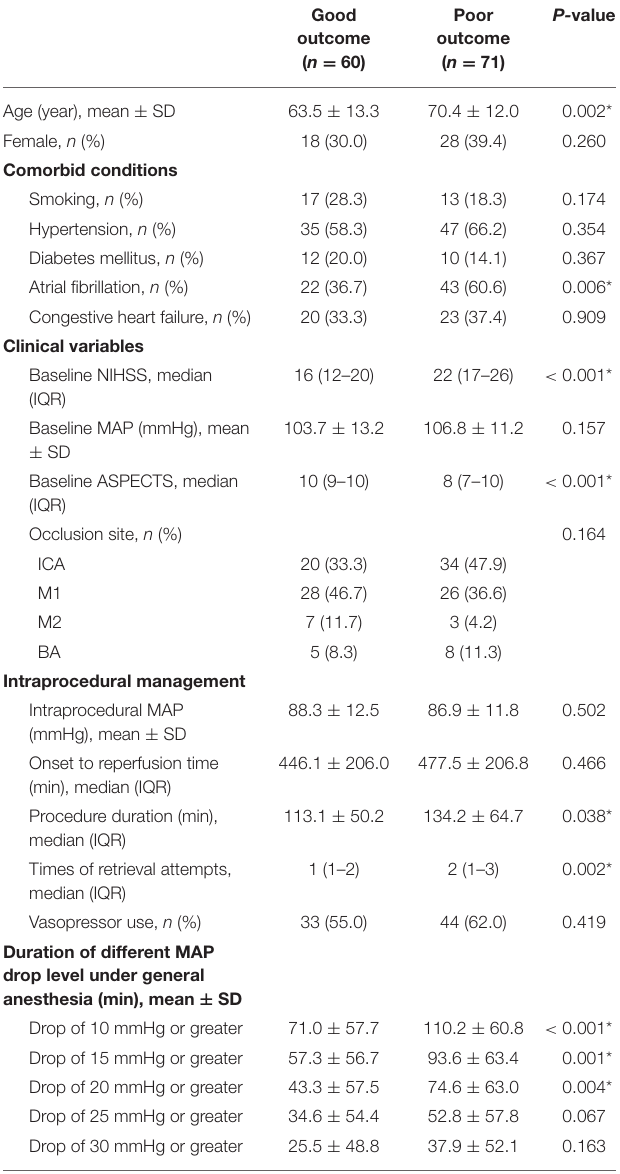
TABLE 1 | Comparison of characteristics between patients with good and poor outcome.